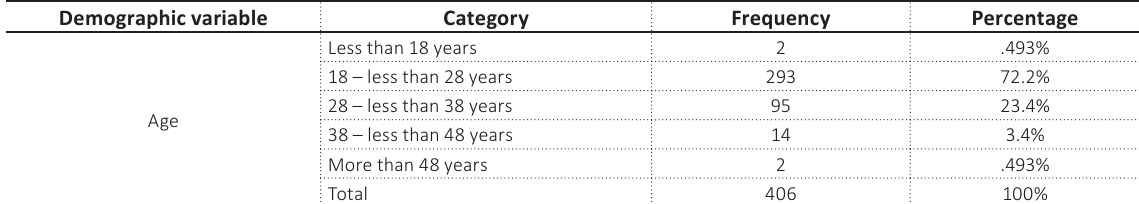
Table 5. Distribution of respondents’ age